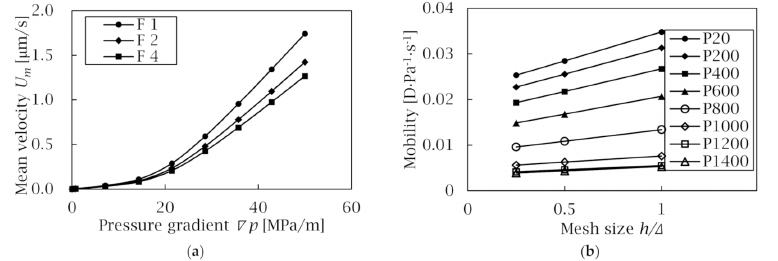
Figure 9. Numerical results for Bingham fluid flow simulation at varying mesh size and pressure gradient. The sample size is N = 100 and resolution ratio is R = 1.0. ( a ) Relationship between flow rate and pressure difference at varying mesh size. The index F in the figure represents the refinement level. F = 2 means that each voxel mesh is divided into 2 3 = 8 reined meshes. ( b ) Mobility (or flow rate) changes linearly with mesh size for varying pressure difference simulation. The index P in the figure represents the pressure difference applied in the